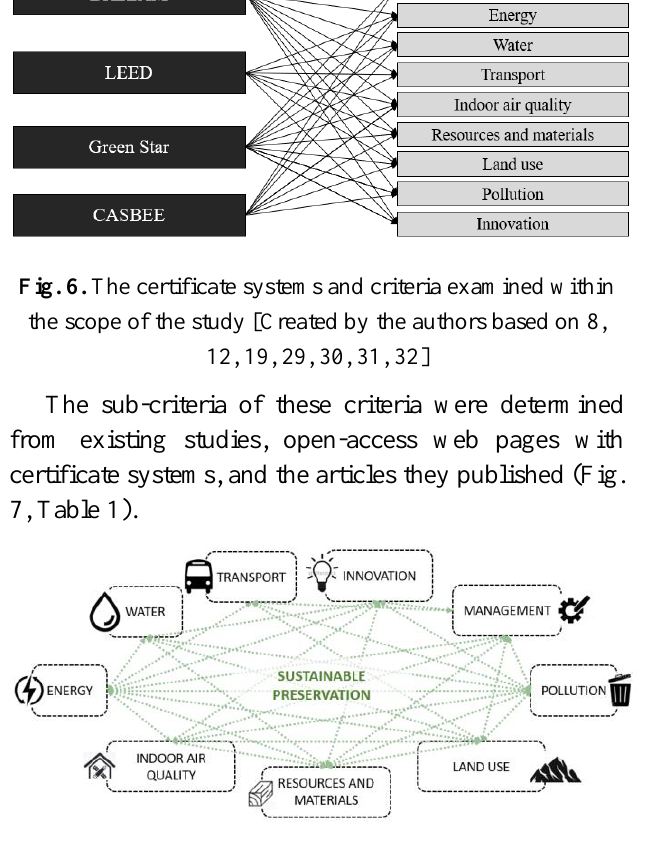
Fig. 7. Relation of common criteria of certification